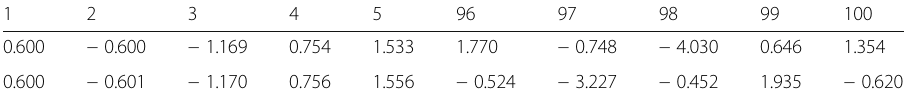
Table 2 The difference of production decision-making caused by the change of k